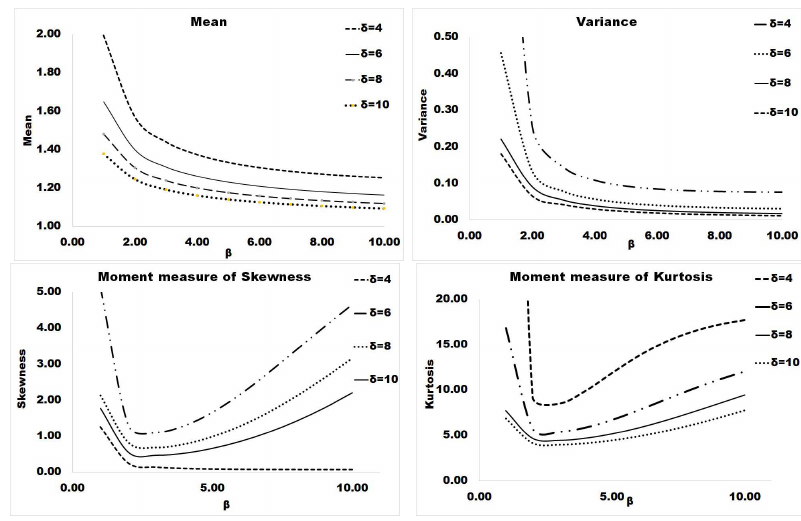
Figure 3 – Mean, variance, skewness and kurtosis for the EKIWD (2 , β, 2 , 2 , 2 , δ ) for particular values of δ